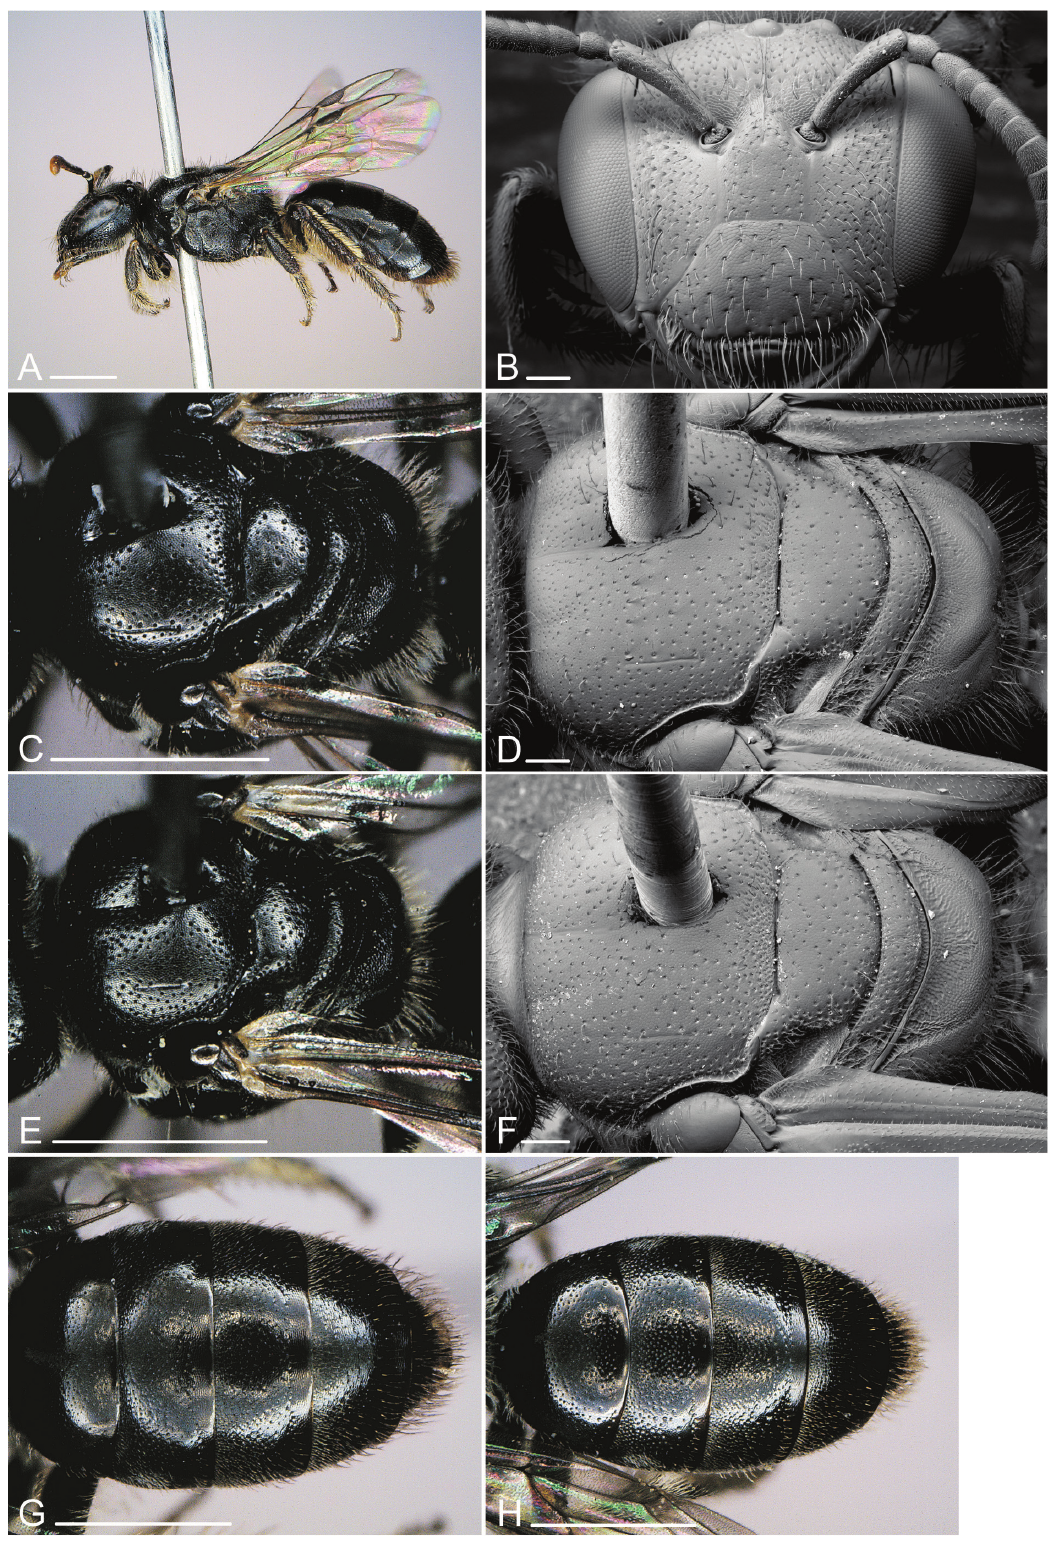
Fig. 21. Scrapter papkuilsi sp. nov., ♀. A . Lateral view. B . Head (SEM). C . Thorax (dorsal view). D . Thorax (dorsal view, SEM). E . Thorax (dorsal view). F . Thorax (dorsal view, SEM). G . Metasoma (dorsal view). H . Metasoma (dorsal view). Scale bars: photos: 1 mm, SEM: 0.1